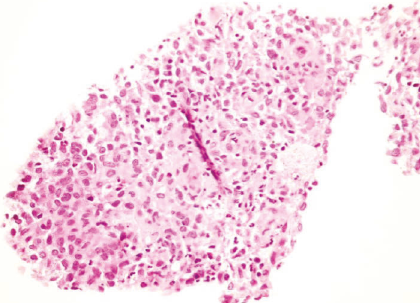
Figure 2: The core biopsy shows the aggregation of histiocyte-like cells, some of which show nuclear grooves. Mitosis and necrosis are not observed.